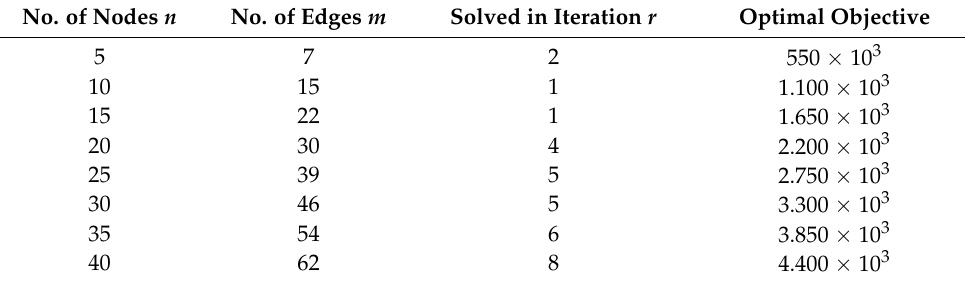
Table 3. Simulation